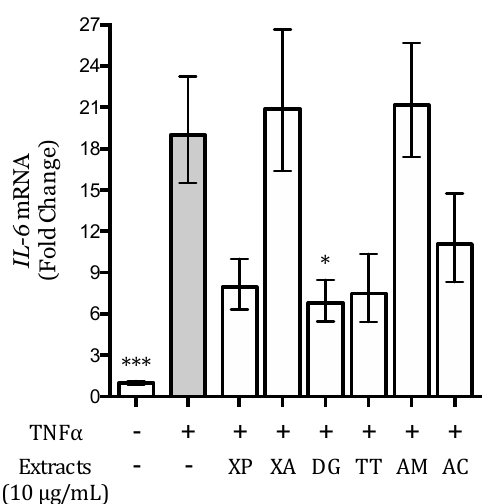
Figure 4. E ff ect of the extracts on IL-6 mRNA levels in gastric epithelial (GES-1) cells. Results are expressed as fold changes versus stimulated control (grey bar). * p < 0.05; *** p < 0.001.